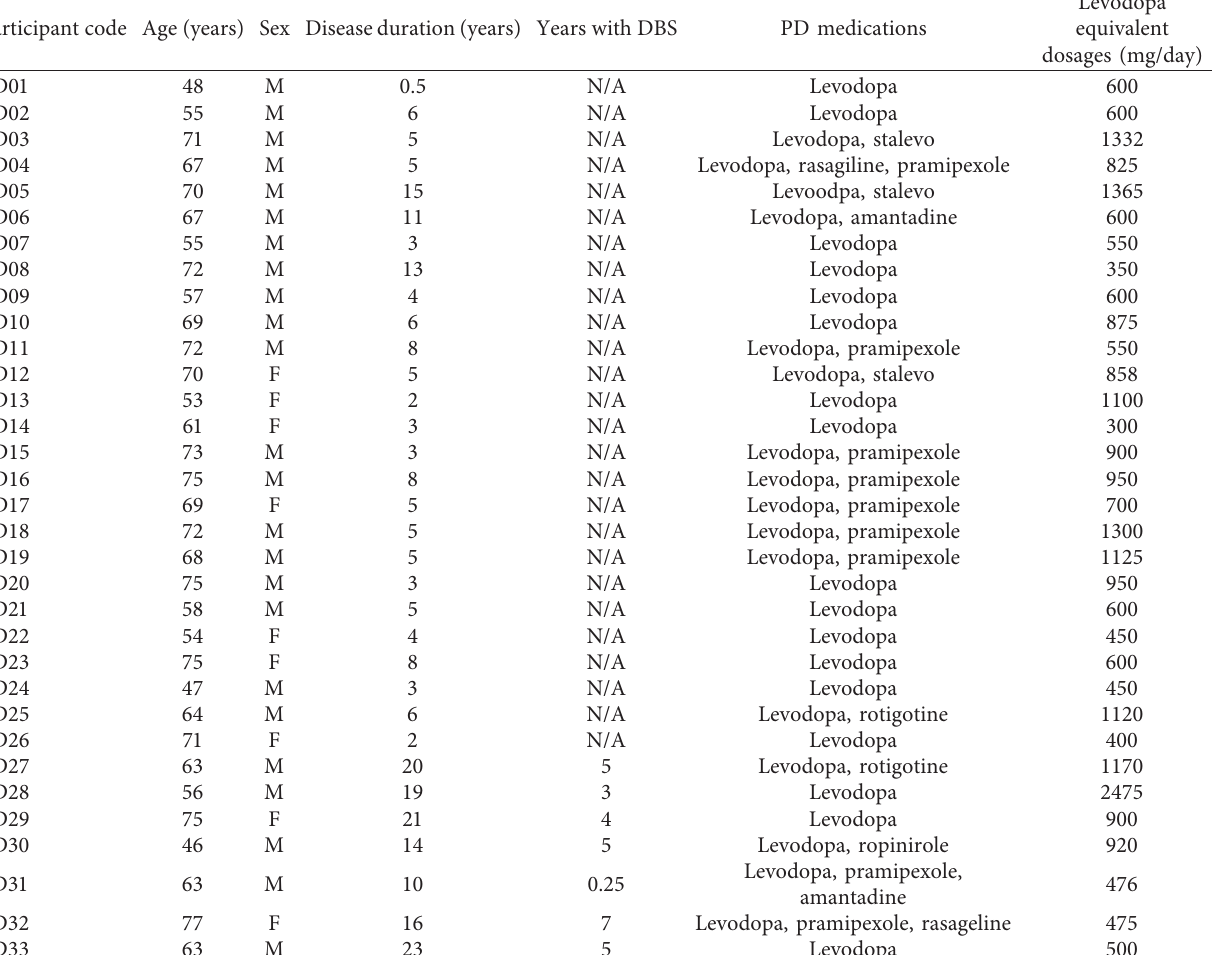
Table 1: Characteristics of subjects with